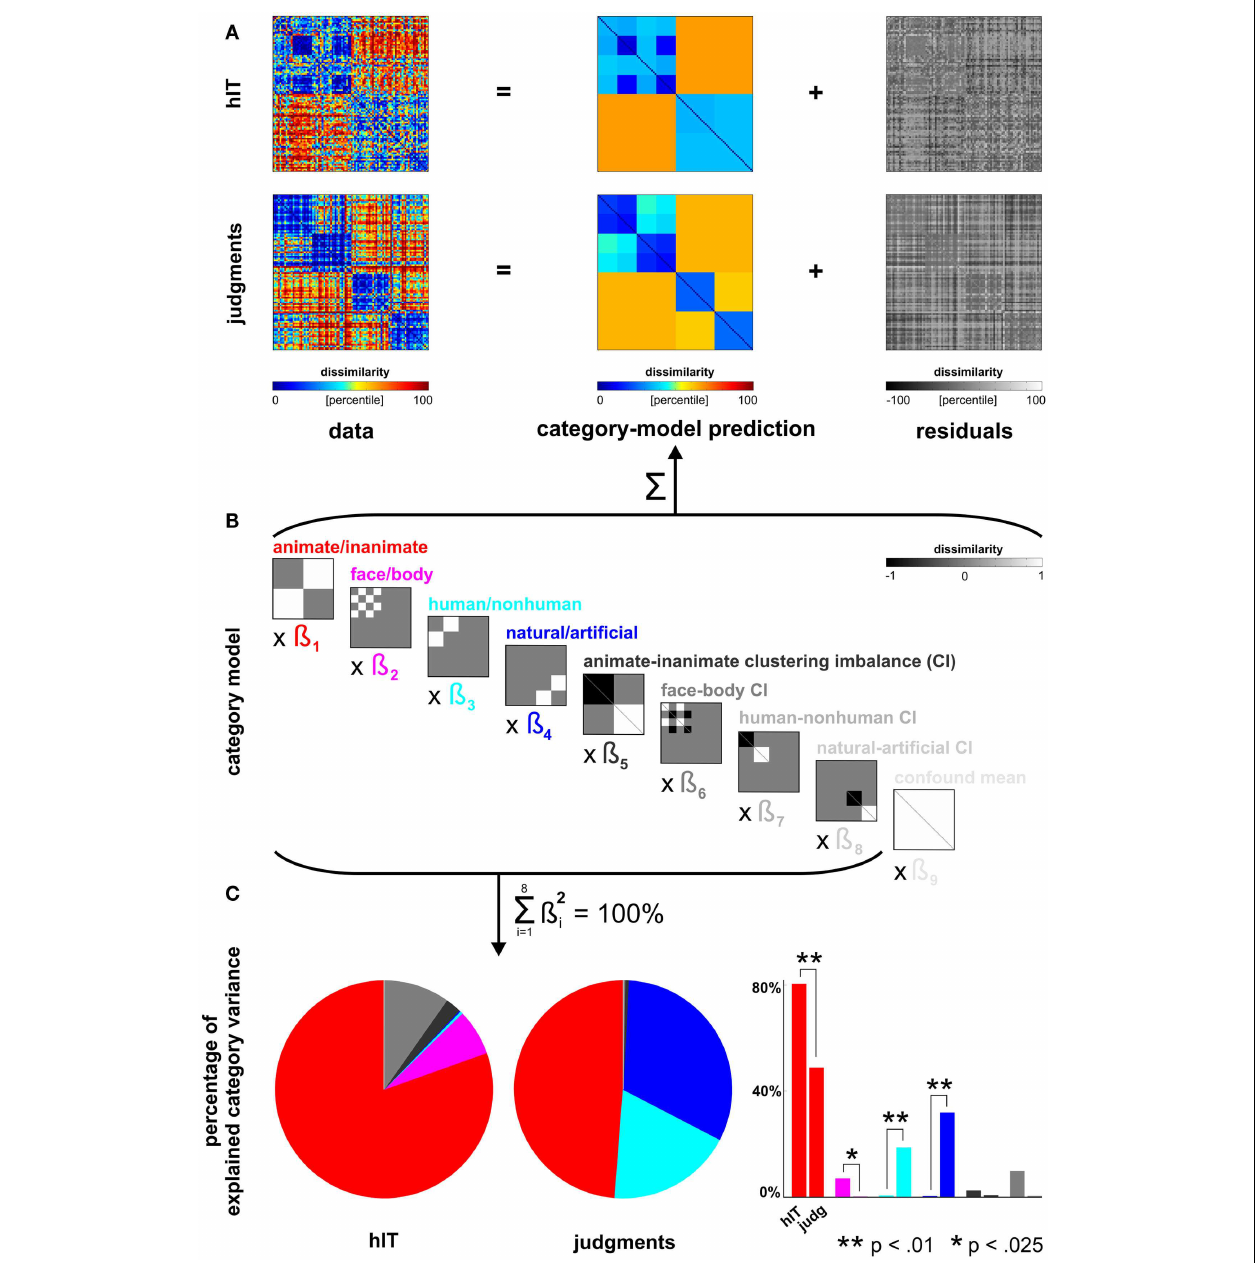
non-category-related dissimilarity variance (residuals).We then equated the proportion of residual variance by adding noise to the RDM with smaller proportion residual variance.The judgments had a smaller proportion of residual variance.The judgments matrix shown in A contains the added noise. Equating the residual variance is necessary for valid statistical inference (for details on the noise model and inference, see Materials and Methods). (C) We then fitted the model to the residual-equated RDMs and compared hIT and judgments in terms of the percentage of category variance explained by each category division.The animate/inanimate and face/body divisions explained significantly more variance in hIT than in the judgments.The human/non-human and natural/artificial divisions explained significantly more variance in the judgments than in